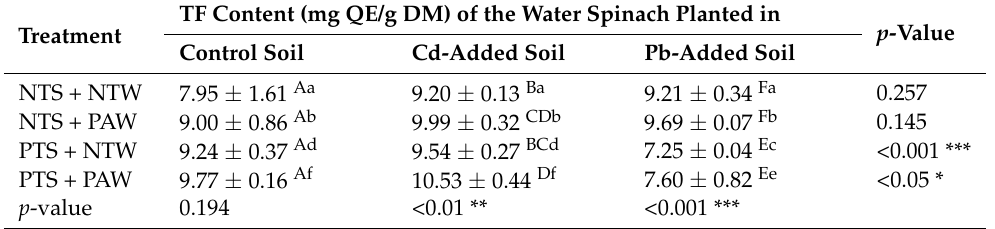
Table 4. Comparison of TF content in water spinach with different plasma treatments grown in different soil of Phase-1 pot experiment.